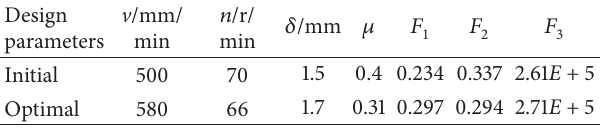
Table 4: Multiobjective optimization results.